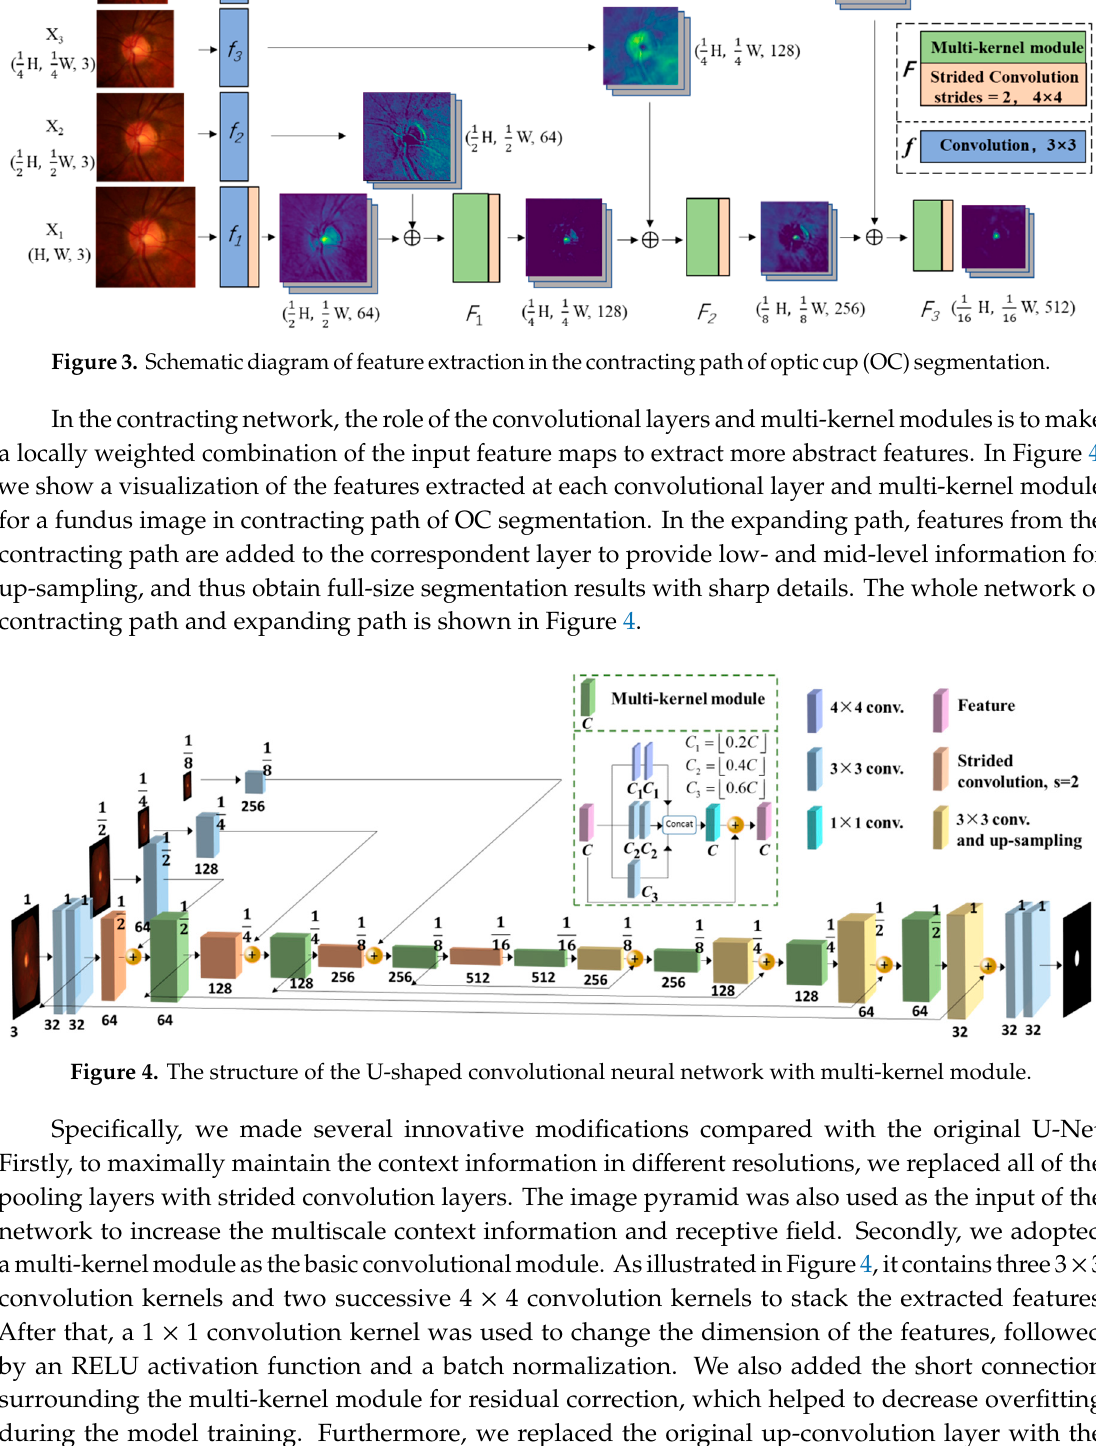
Figure 4. The structure of the U-shaped convolutional neural network with multi-kernel module.